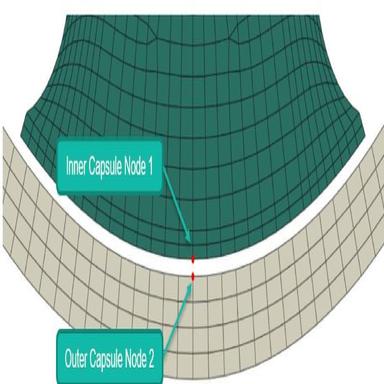
Shows a top-down cross section view of the gas gap between in the inner and outer capsule.